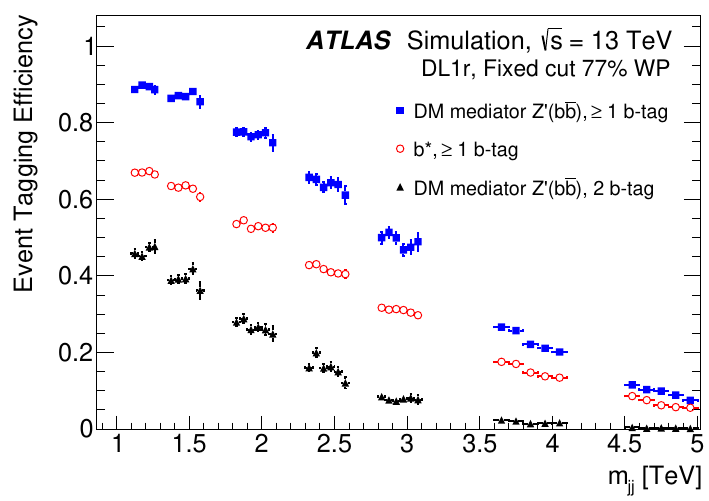
Figure 2 . The probability of an event to pass the b -tagging requirement after the rest of the event selection, shown as a function of the resonance mass m